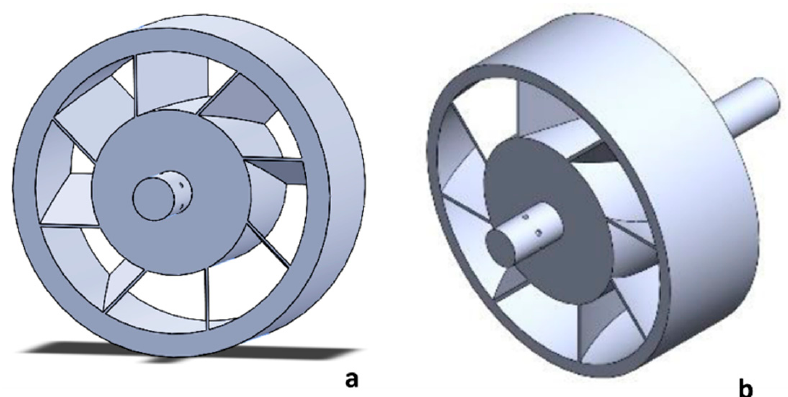
Figure 2. Optimized swirler with fuel injector: ( a ) front view; ( b ) isometric view. The dilution zone cools down the flame to obtain an appropriate temperature at the outlet of the CC. This zone is located at L = 24 cm from the inlet of the